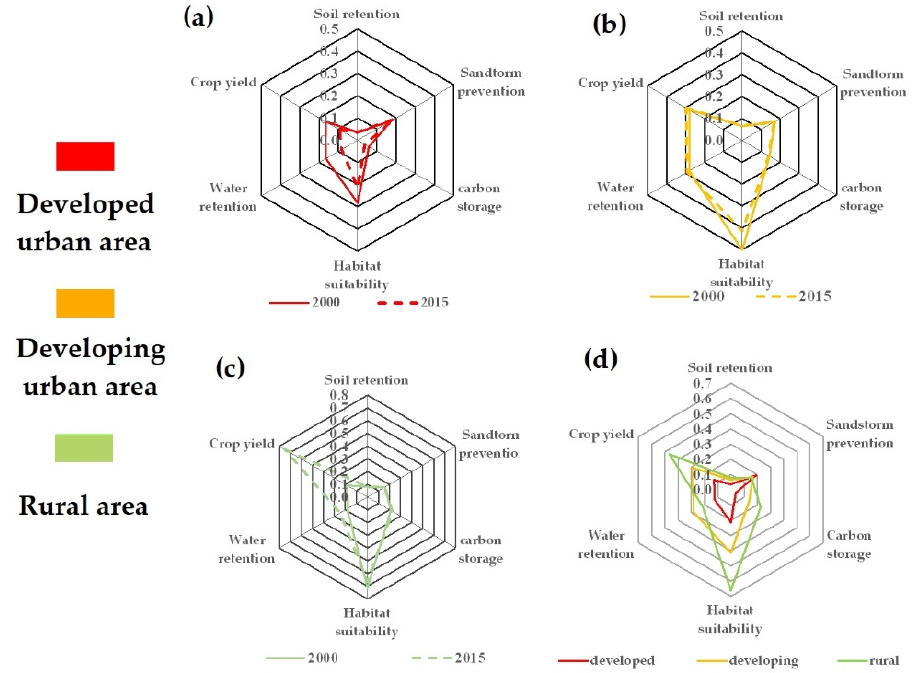
Figure 6. Radar maps of ESs in ( a ) developed urban area, ( b ) developing urban area, ( c ) rural area, and ( d ) the mean value of ESs in three areas.